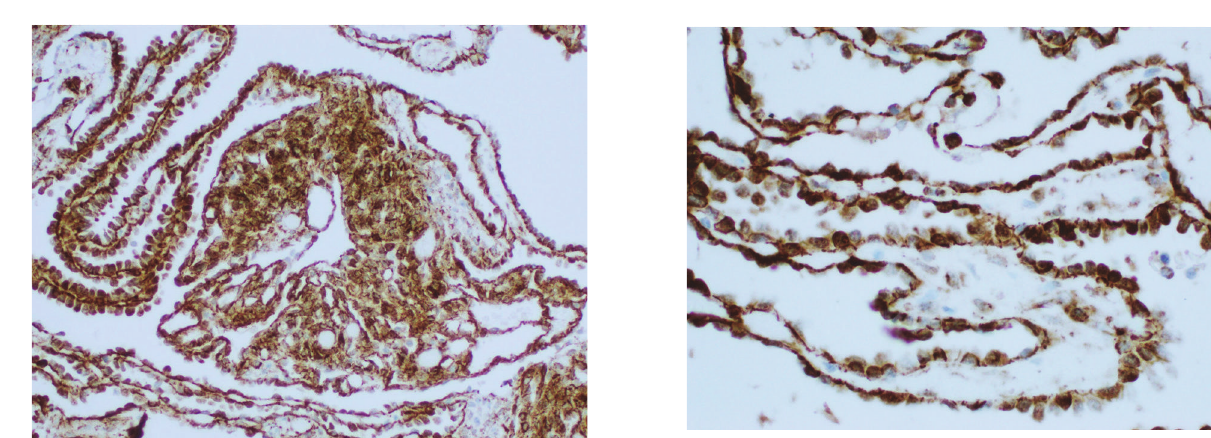
Figure 7: Nuclear and cytoplasmic beta-catenin positivity in reti- form areas and focal solid areas composed of sheets of Sertoli cells (200x).